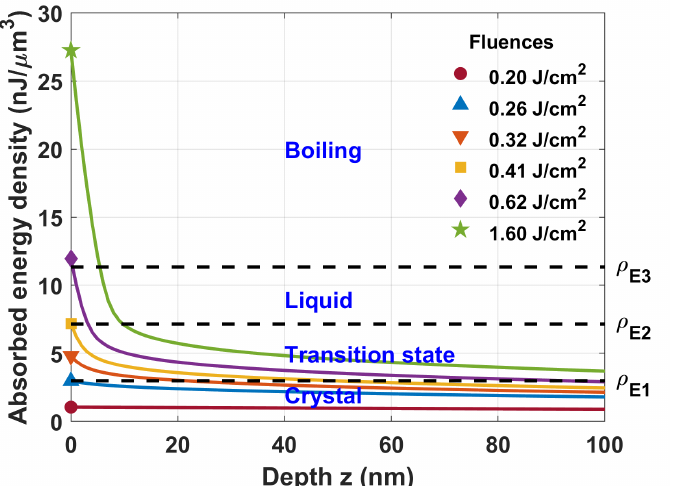
Figure 5. Calculated absorbed energy density as a function of depth for different fluence values. Model parameters: τ c = 64.6 fs, τ R = 161 fs, and β = 18.0 cm/GW. Limiting energy densities: ρ E 1 = 2.987 nJ/ µ m 3 (requires to reach the melting point), ρ E 2 = 7.158 nJ/ µ m 3 (requires to transform solid silicon into liquid phase), ρ E 3 = 11.334 µ m 3 (requires to reach the boiling